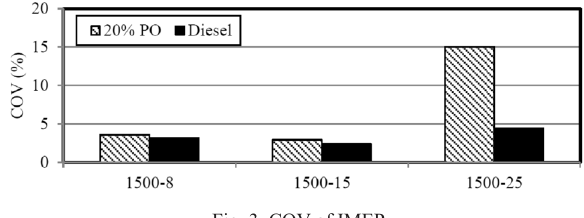
Fig. 3. COV of IMEP